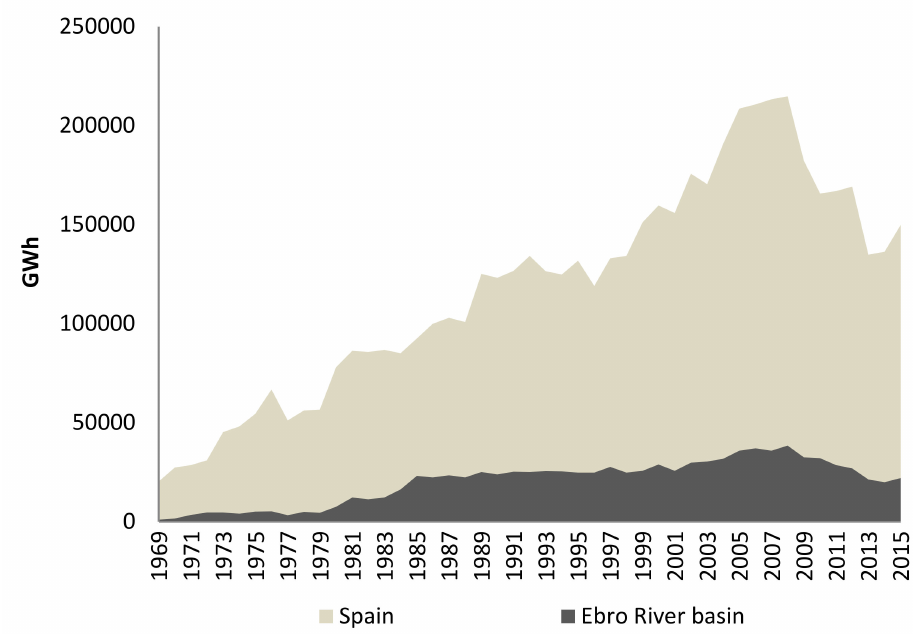
Figure 2. Evolution of thermal power generation in the Ebro River basin within the Spanish thermal power generation system, 1969–2015. Source: own design using data from Spanish Association of Electrical Industry (UNESA) and Red El é ctrica de España